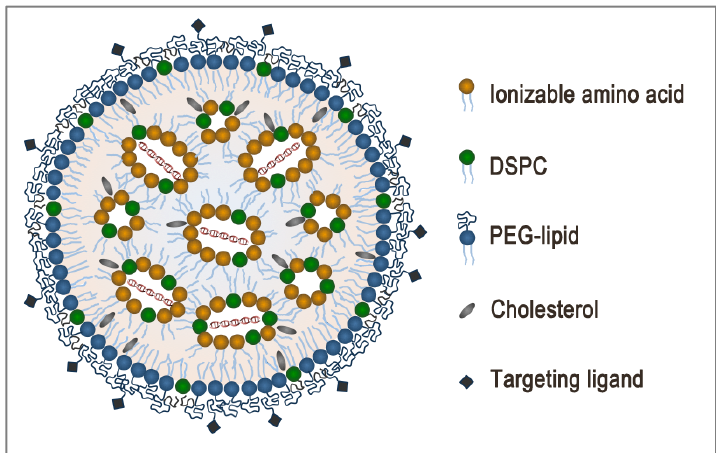
Figure 2. A schematic of LNP siRNA showing a nanostructured